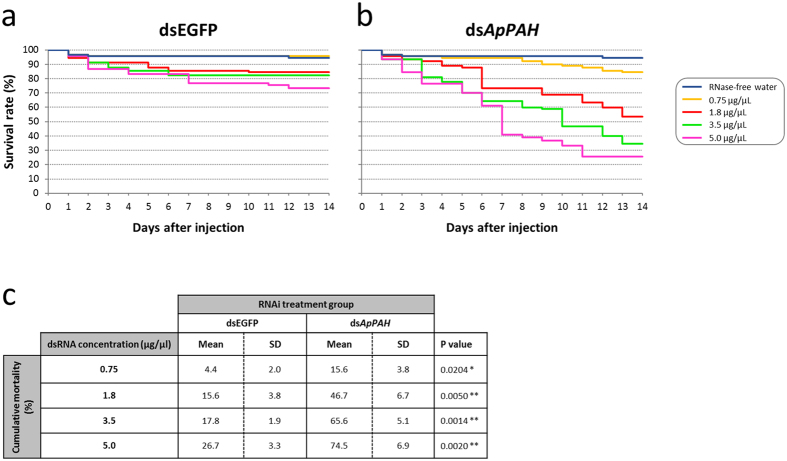
Impact of dsApPAH on aphid survival.(a,b) Survival curves of aphids injected with dsEGFP (a) or dsApPAH (b), at different dsRNA concentrations. Results are reported as means, n = 3 independent biological replicates (30 aphids per biological replicate). (c) Cumulative mortality of RNAi treated-aphids. Results are reported as means ± SD, n = 3 independent biological replicates (30 aphids per biological replicate). For each dsRNA concentration, significant differences between dsEGFP and dsApPAH-treated groups were analyzed by a Student’s t-test and are indicated with asterisks (*P < 0.05; **P < 0.01).